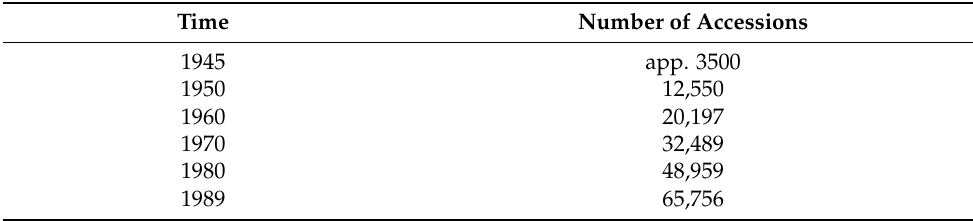
Table 1. Size of genebank collections maintained at Gatersleben